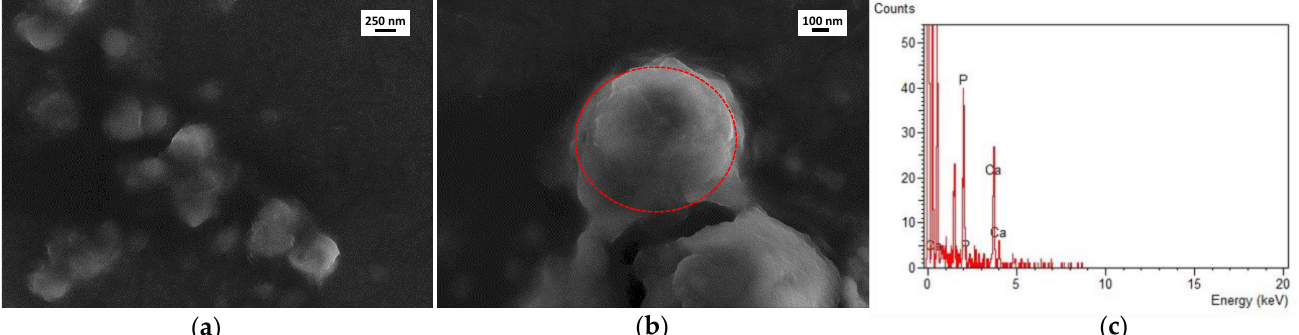
Figure 4. FESEM micrographs of CaP-NP NEG 1B at different magnifications ( a ) 5000 × , ( b ) 10,000 × . Panel ( c ) shows the EDS spectrum of the region highlighted in ( b ) by the red dashed circle. FESEM images collected at 25 kV with the standard SE detector.